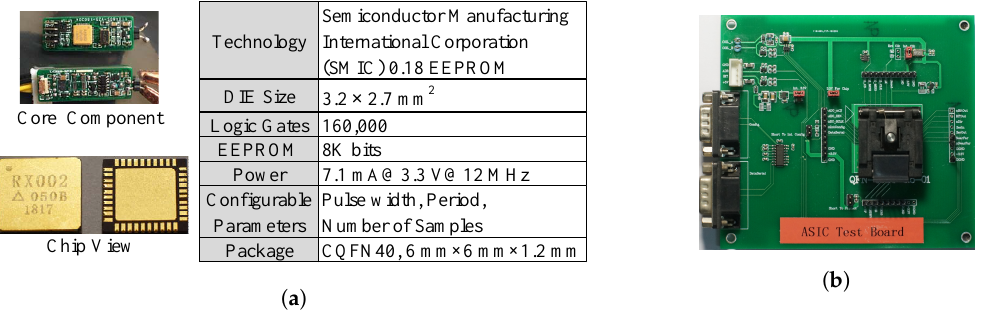
Figure 9. ( a ) Chip info (the ASIC chip is fabricated in the 0.18 µm CMOS process and encapsulated in a 40-pin CQFN); ( b ) evaluation PCB board (the size of the board is 10 mm × 25